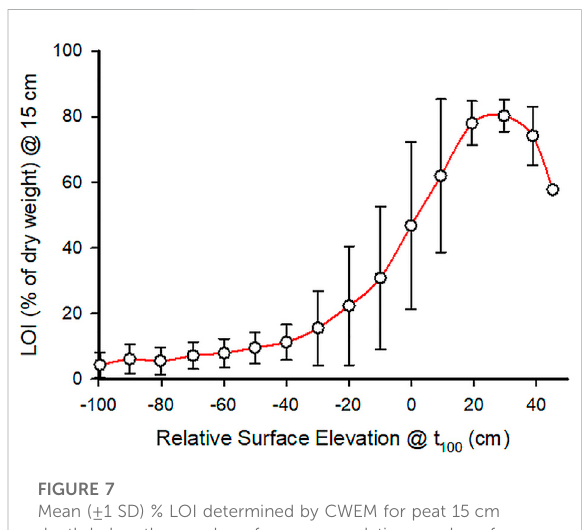
FIGURE 7 Mean (±1 SD) % LOI determined by CWEM for peat 15 cm depth below the marsh surface versus relative marsh surface elevation (relative to MSL at time = 100 years) from permutations of centenary SLR between 40 and 200 cm and IRE between − 97 and 68